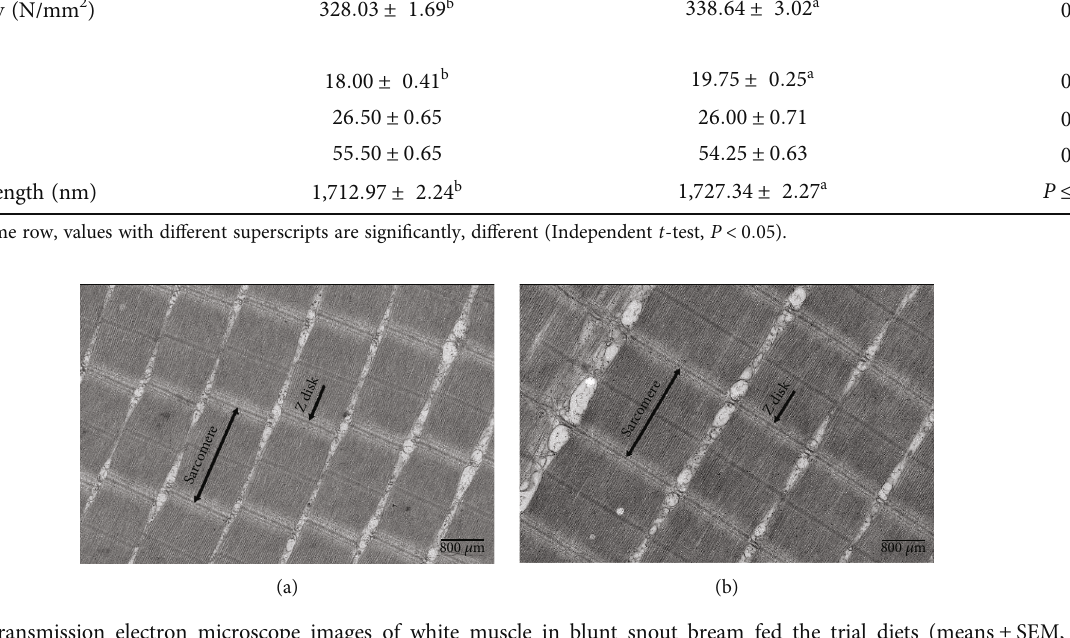
Figure 3: Transmission electron microscope images of white muscle in blunt snout bream fed the trial diets ( means ± SEM , n = 4 ). Photomicrographs ( × 8000 ) and scale bar (800nm). The distance between the two-way arrows indicates is the sarcomere lengths (SL). The line pointed by the one-way arrow is the Z disk. (a) fi sh fed LL diets; (b) fi sh fed HL